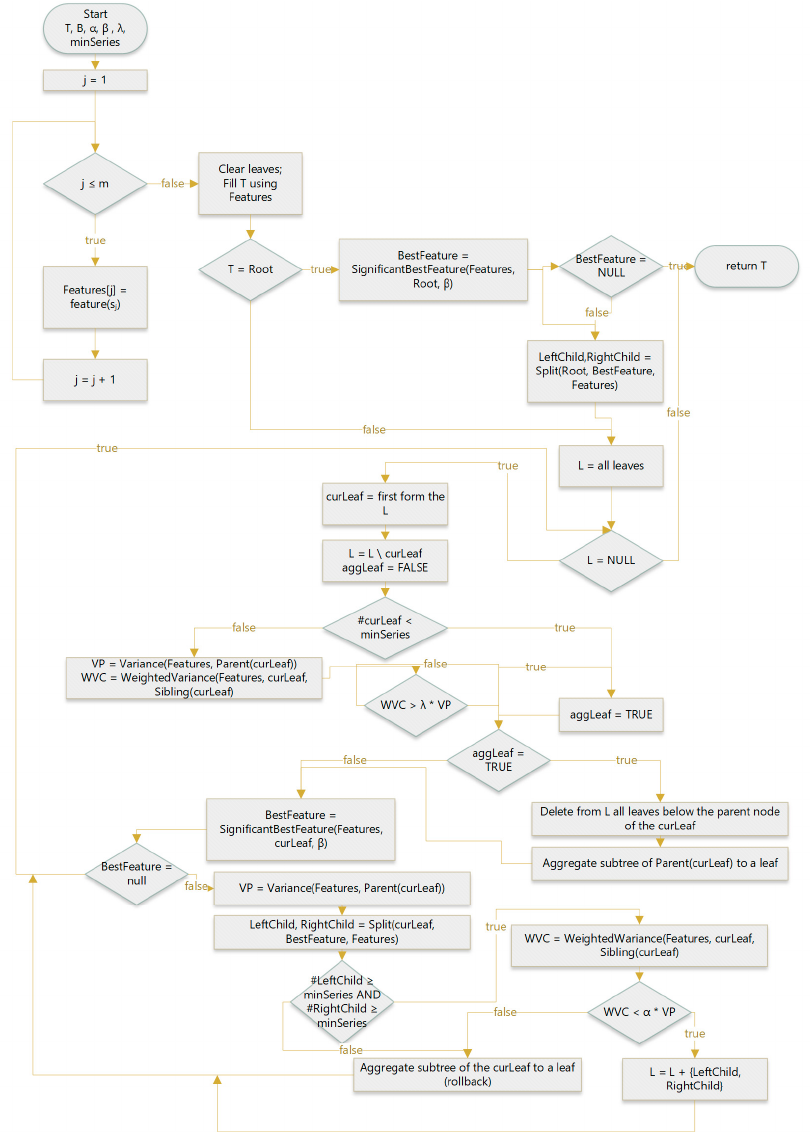
Figure A9. Flowchart for Algorithm 1 (for clarity, in some cases we have used abbreviations).